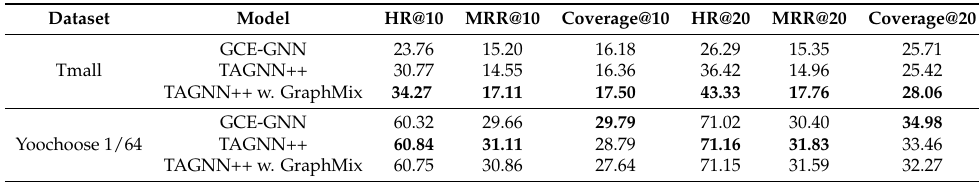
Table 4. The performance comparison on our proposed model with TAGNN++ and GCE-GNN using Tmall and Yoochoose 1/64